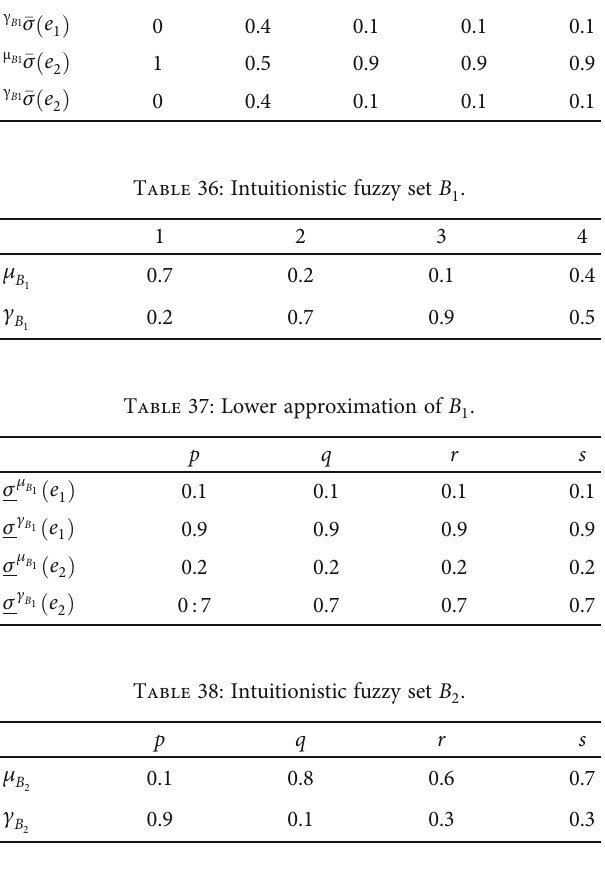
Table 35: Upper approximation of B